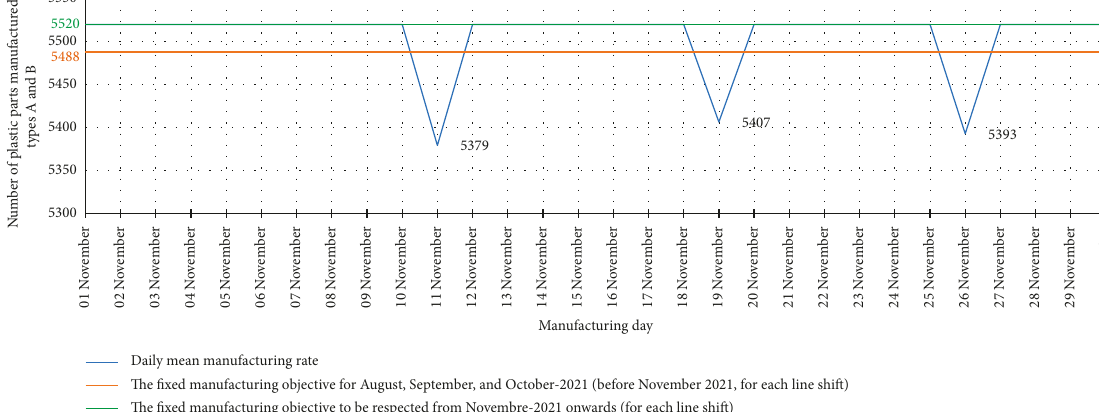
06h 46 min/shift) and fixed manufacturing (cid:31)